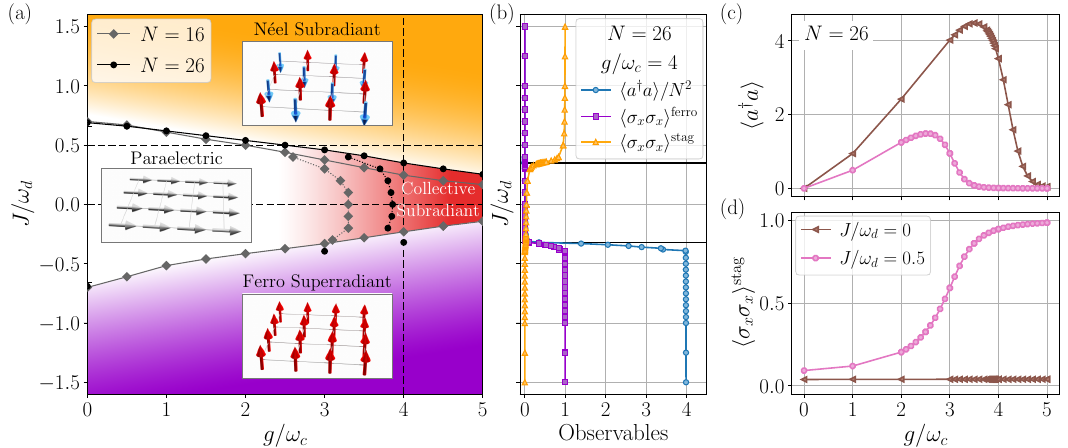
Figure 2: Cavity QED ground states on the square lattice. (a) Phase diagram of H . cQED The symbols track the boundaries between distinct ground states estimated for differ- ent system sizes N , solid (dotted) lines indicate phase transitions (crossovers). The insets show sketches of the spin configurations in the corresponding phases. (b) Or- = 4. (c-d) Ground state photon number der parameter correlations for a cut at g /ω c (c) and order parameter correlations (d) for the transitions from the paraelectric to the subradiant phases with 〈 a † a 〉 (cid:39) 0 along the horizontal dashed lines in (a). For small dipole-dipole interactions, J /ω , the collective subradiant regime is stabilized d by increasing g /ω while the spins remain disordered (brown curves). For non-zero c > 0, the system undergoes a phase transition to antiferroelectric interactions, J /ω d the Néel subradiant phase, where 〈 a † a 〉 vanishes simultaneously with the onset of σ 〉 stag → 1 (pink antiferroelectric Néel order, 〈 σ x x